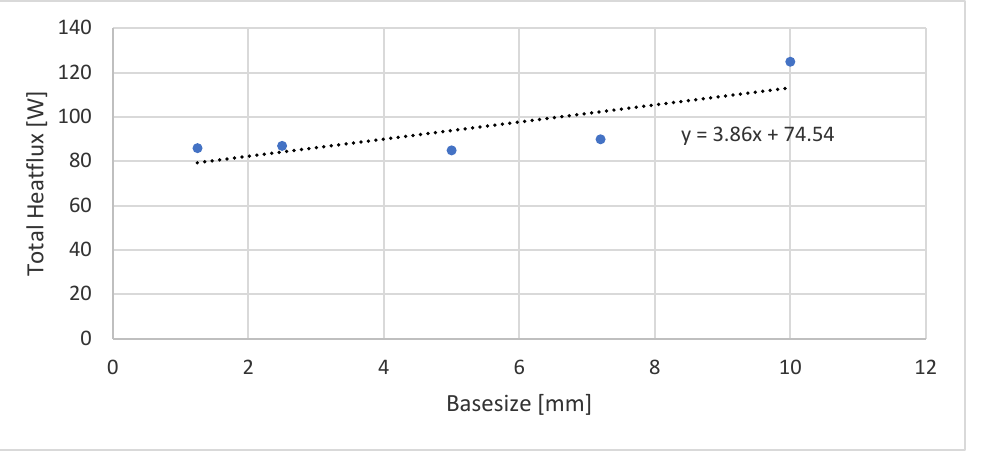
Figure 1. Grid independence for the mesh.